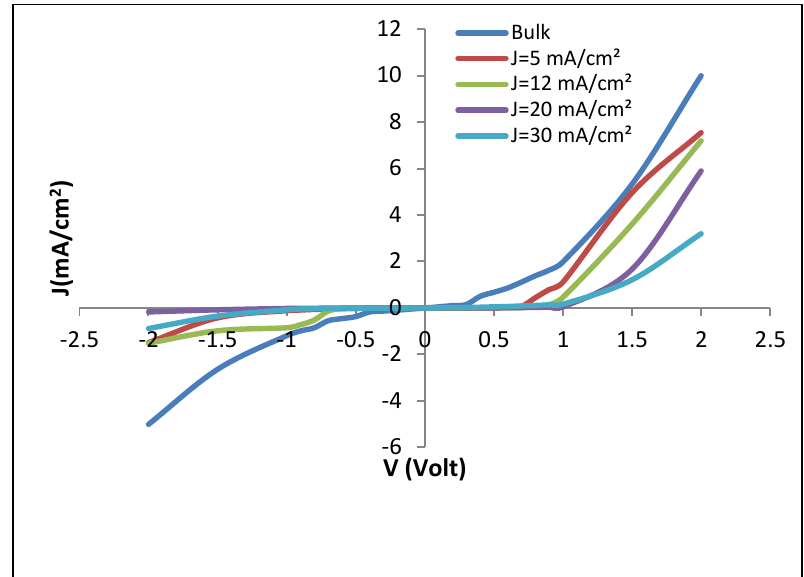
Fig. 7: The current density-Voltage characteristics of c-Si and PS prepared with different current density (J), and fixed etching time was 15 min and the HF concentration was